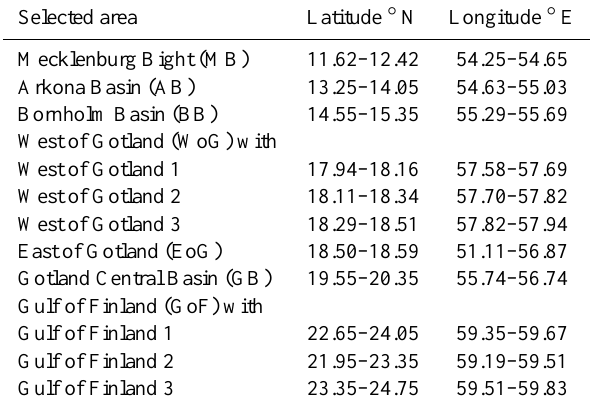
Table 1. For detailed contemplations of regional differences spe- cial key areas were selected to merge methane data (saturation val- ues) with mixing depth or meteorological forcing data derived from the regional forecast model COSMO/EU. The subdivision of the area WoG and GoF reflects a better description of the field of in- terest than one large box, respectively, and improves the technical approach during